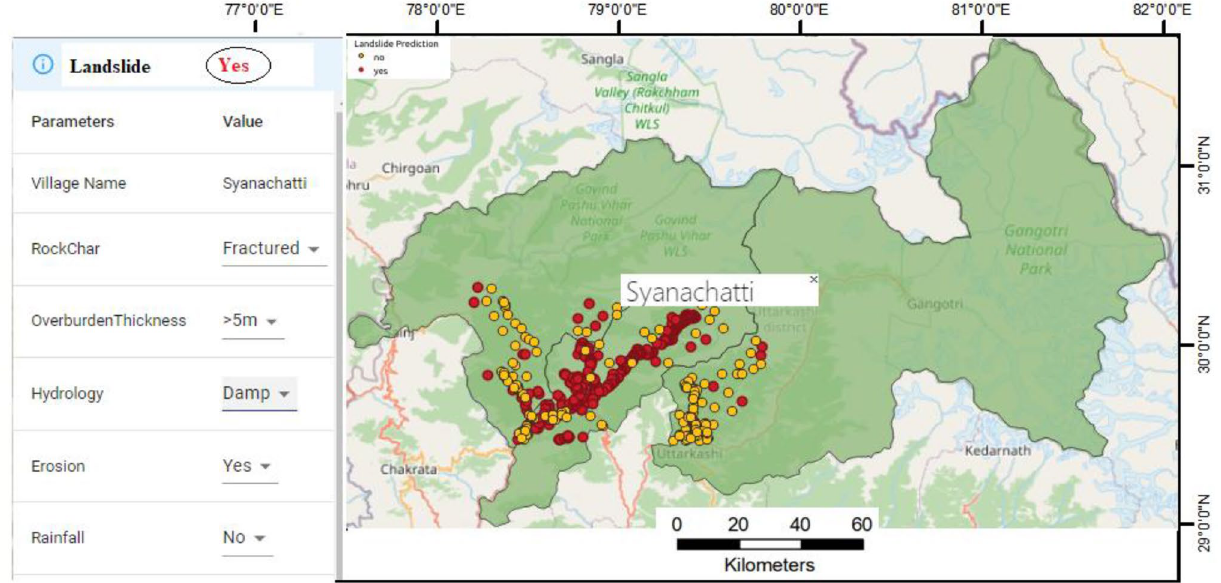
Figure 9. GIS based user interface to predict the possibility of landslide and non-landslide events on changing the values of landslide conditioning factors considered for the study